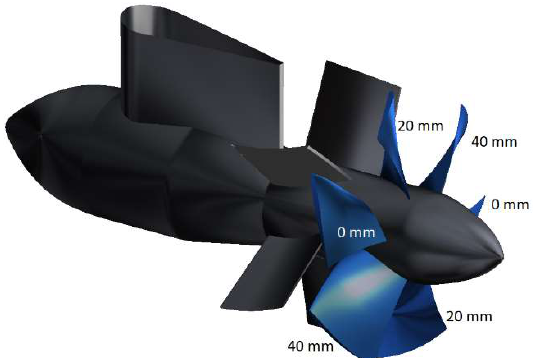
Fig. 3 The impeller with various offsets of